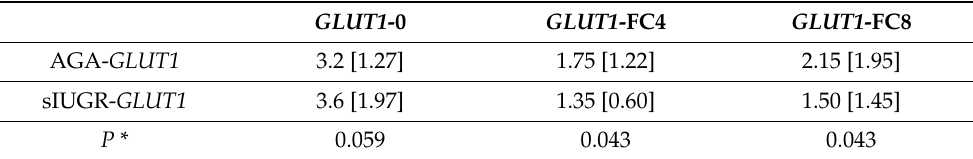
GLUT1 -0: GLUT1 Gene expression at normal oxygen concentration culture. GLUT1 -FC4: GLUT1 gene expression fold changes after four hours hypoxia culture. GLUT1 -FC8: GLUT1 gene expression fold changes after eight hours hypoxia culture. Gene expression at normal culture are expressed as relative expression comparing to GAPDH expression ( GLUT1 / GAPDH ). GLUT1 -FC4 and GLUT1 -FC8 are expressed as gene expression at four (eight) hours of hypoxia culture/gene expression at normal oxygen culture. Data are expressed as median [inter-quartile range]. P *: p value of FCs between PMSCs of AGA and sIUGR fetuses at four or eight hours of hypoxia culture. p values were generated by Wilcoxon signed-rank test.